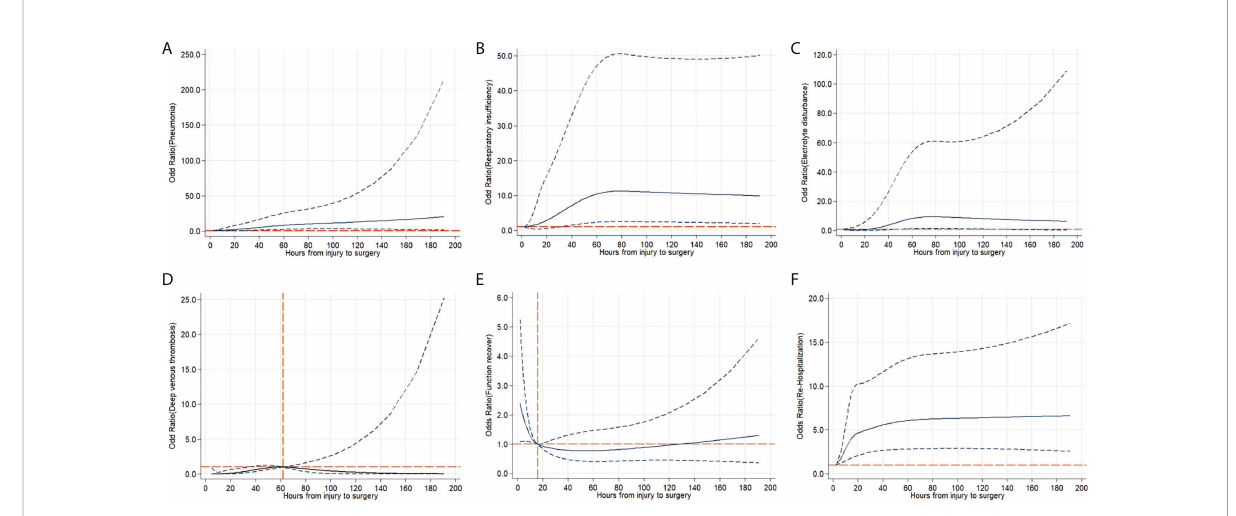
FIGURE 2 Adjusted cubic spline models showing the association between surgery timing and the incidence of complications (A-D) , functional recovery (E) and rehospitalization (F) . Models were adjusted for age, sex, injury factors, fracture level and comorbidities. The solid line and long dashed line represent the estimated odds ratio and its 95% con fi dence interval. Knots are at the 5th, 35th, 65th and 95th percentiles for metabolic